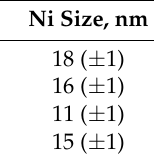
Table 3. Ni nanosize as determined by Rietveld method.